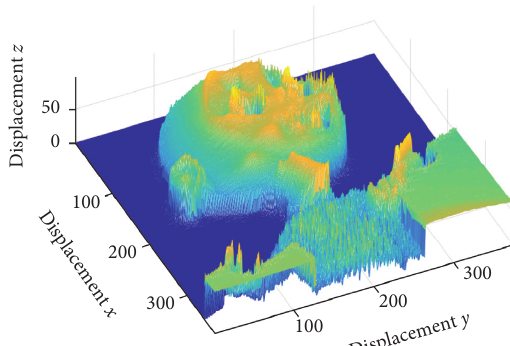
Figure 10: 3D modeling effect of multivisual animation characters based on VR.